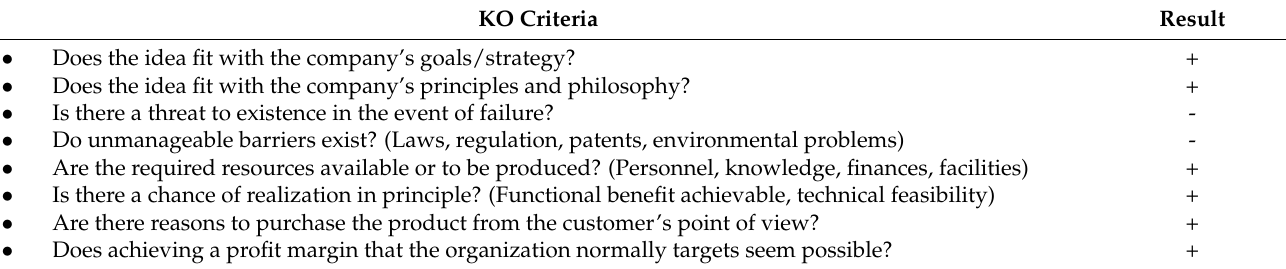
Table 1. KO criteria for checking the general suitability of product ideas, based on